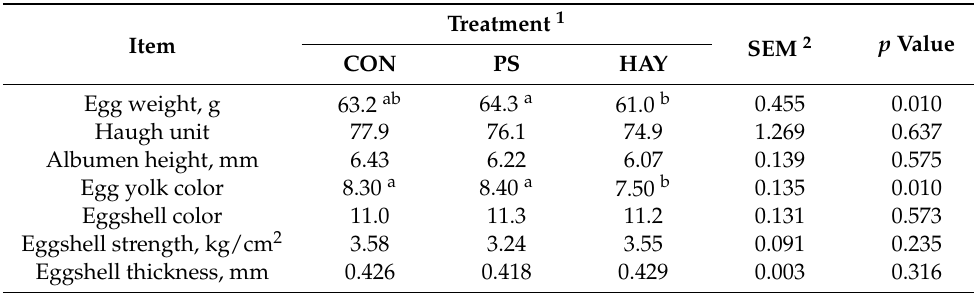
Table 2. Means of internal egg quality indicators of laying hens according to environmental enrich- ment